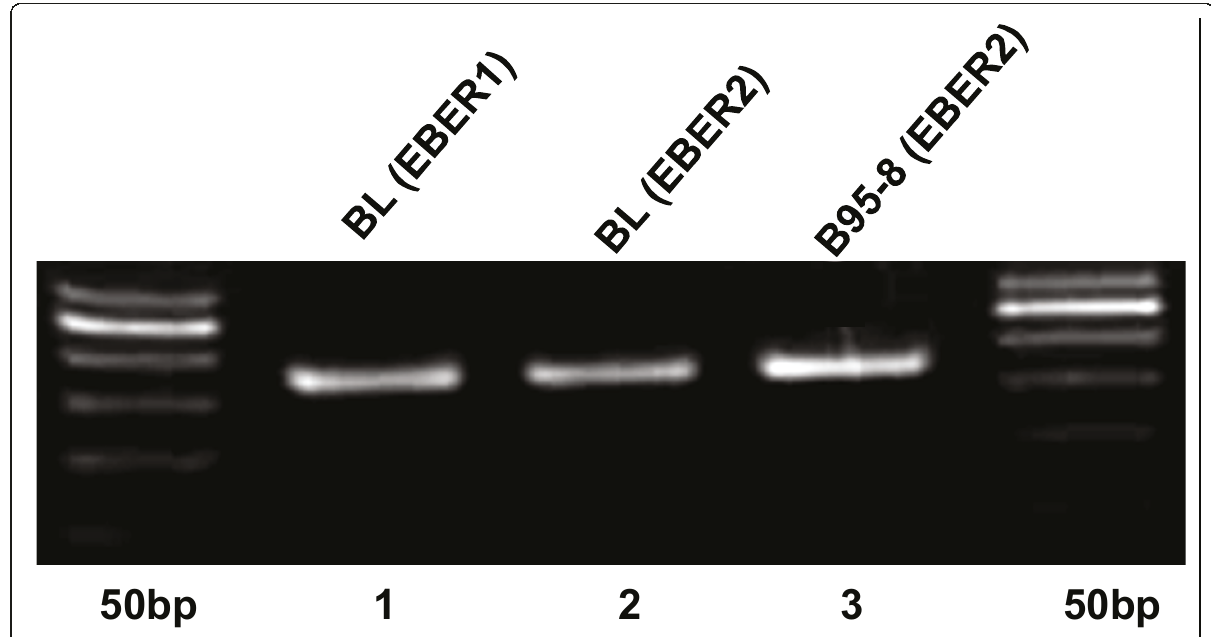
Figure 2 Qualitative PCR assay system : Results of Agarose Gel Electrophoresis of EBER1 and EBER2 genomic DNA fragment in EBV positive Burkitt ’ s lymphoma (BL) samples. Lane 1 (left-to-right) 50 bp ladder, Lane 2 166 bp EBER1, Lane 3 172 bp EBER2, Lane 4 EBER 2 172 bp (B95-8), positive control, Lane 5 50 bp